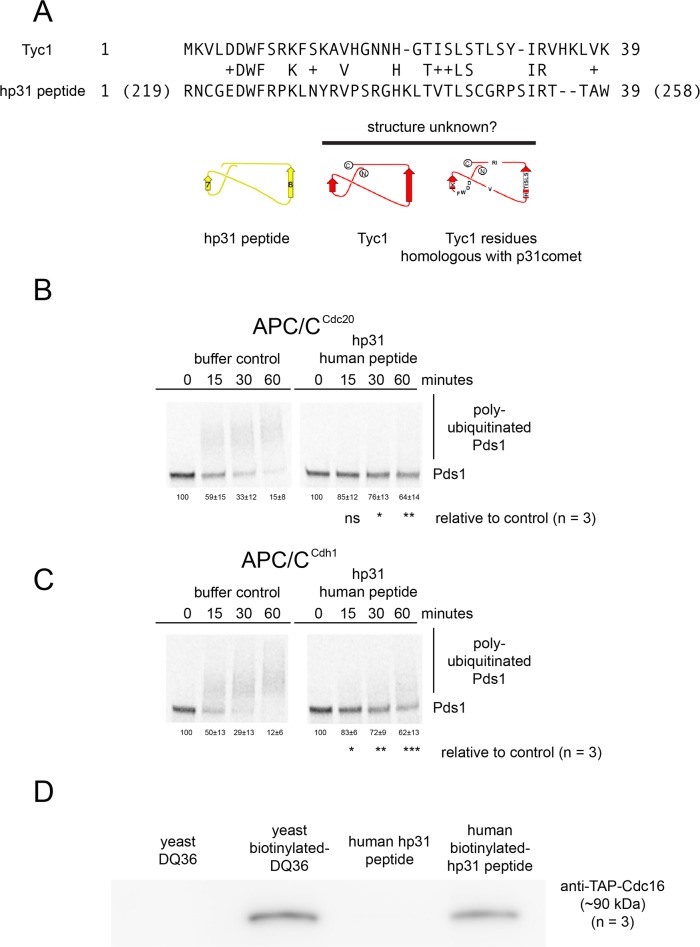
The human peptide hp31 inhibits budding yeast APC/C activity and binds to yeast APC/C.A) An alignment between budding yeast Tyc1 and the synthesized human hp31 peptide derived from human p31comet. B) Phosphor-images show that 220 μM human hp31 peptide inhibits yeast APC/CCdc20. C) Phosphor-images show that 220 μM human hp31 peptide inhibits yeast APC/CCdh1. D) The human-derived hp31 can pull-down budding yeast APC/C at 20 μM peptide (n = 3).